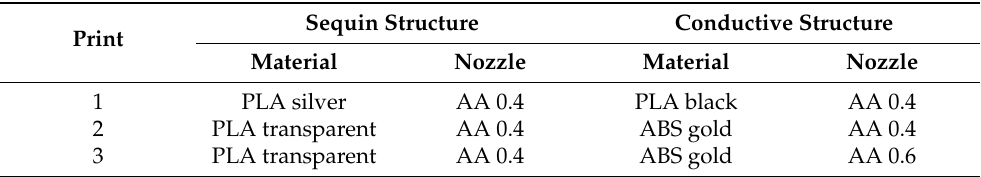
Table 1. 3D printing combination of materials and nozzles.